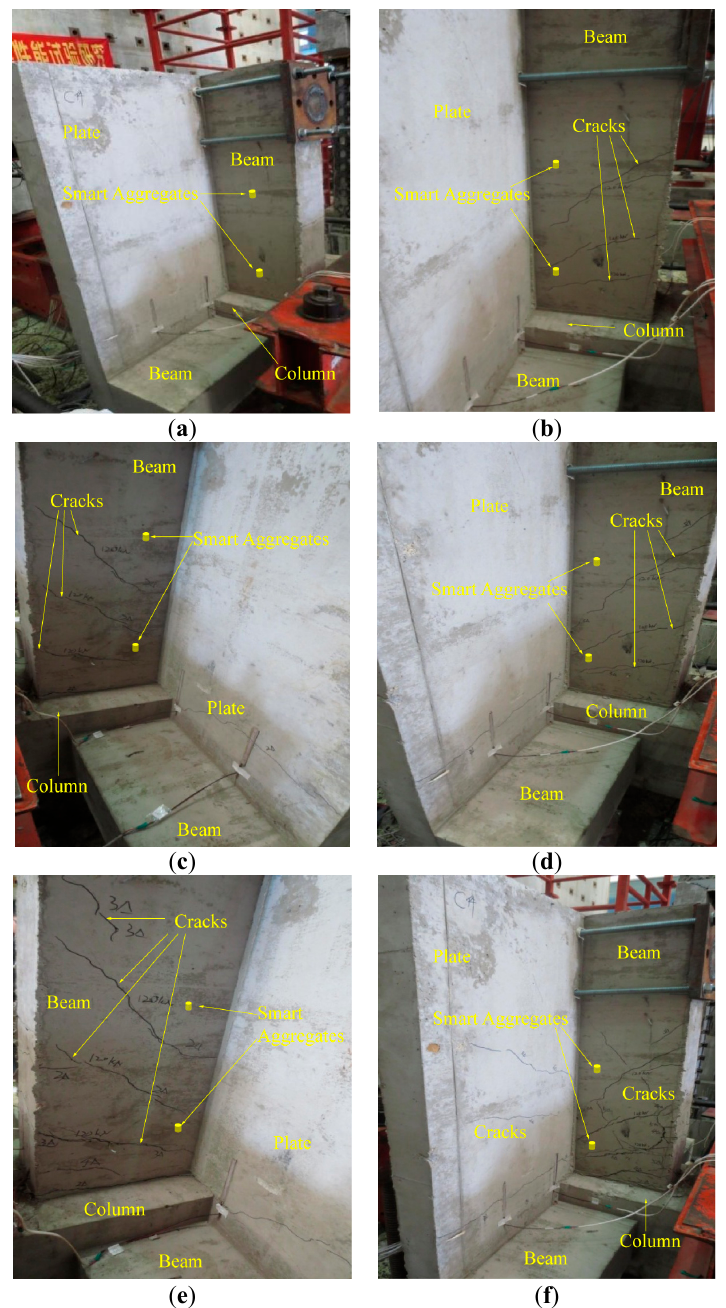
Figure 18. The different damage states of the specimen. ( a ) The original health status; ( b ) 1 △; ( c ) 2 △; ( d ) 3 △; ( e) 4 △; ( f ) 5 △ .